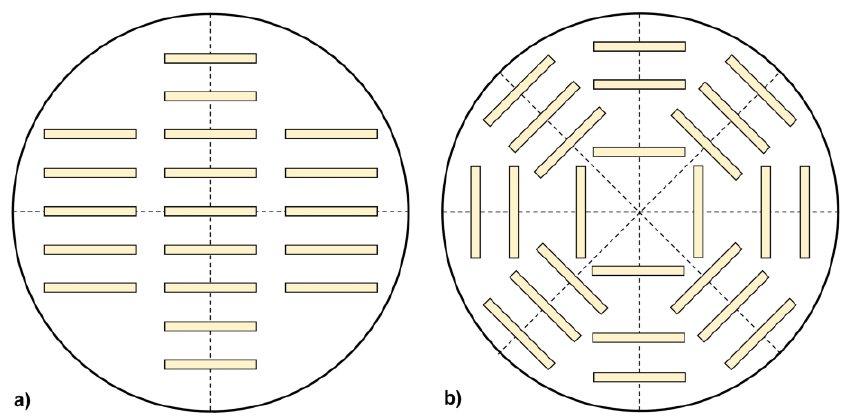
Figure 10. Considered options for the arrangement of seeds in a large reactor (top view of cross- section through the interior of an autoclave). Seeds are represented by yellowish rectangles. Dashed lines indicate mirror planes. ( a ) Example for conventional seed arrangement; ( b ) Proposed seed ar- rangement to reduce the length of radiographed path through GaN for improving X-ray transpar- ency.